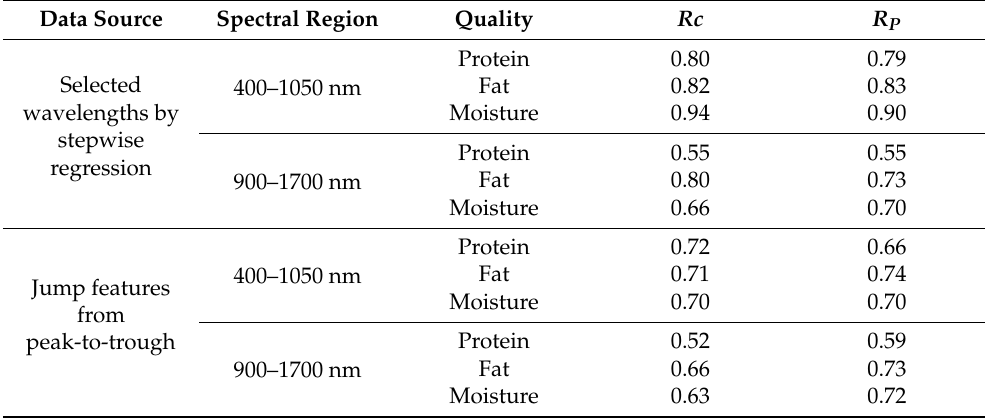
Table 5. Multiple linear regression modeling results based on the selected wavelengths and peak valley jump characteristics without